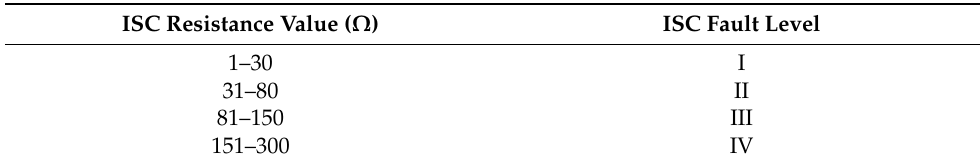
Table 2. Levels corresponding to different ISC resistance values of the battery.